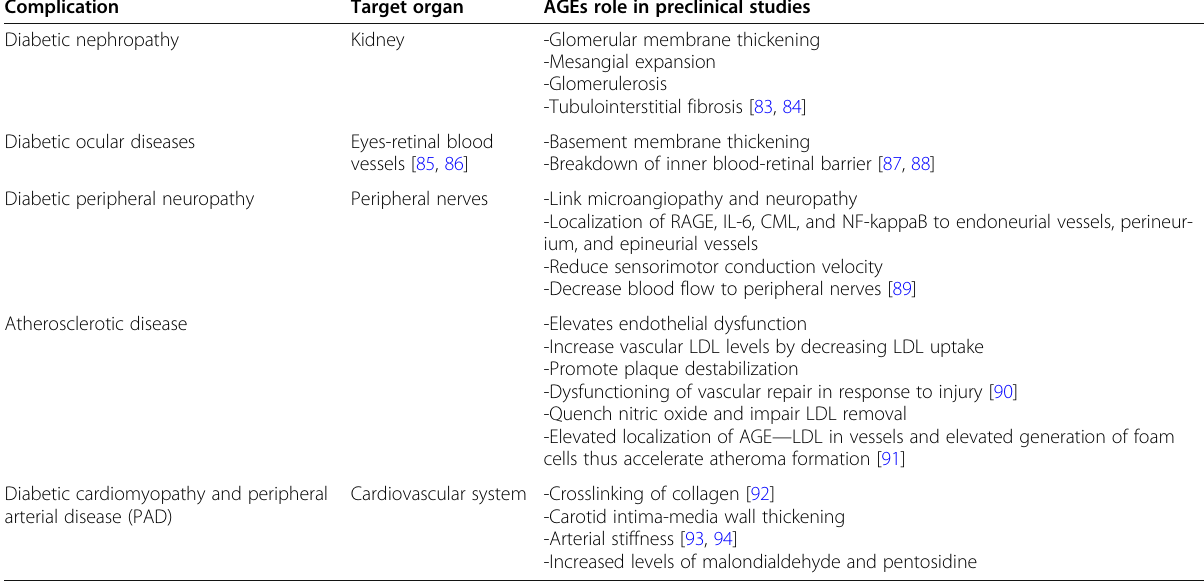
Table 4 Effect of AGEs accumulation on target